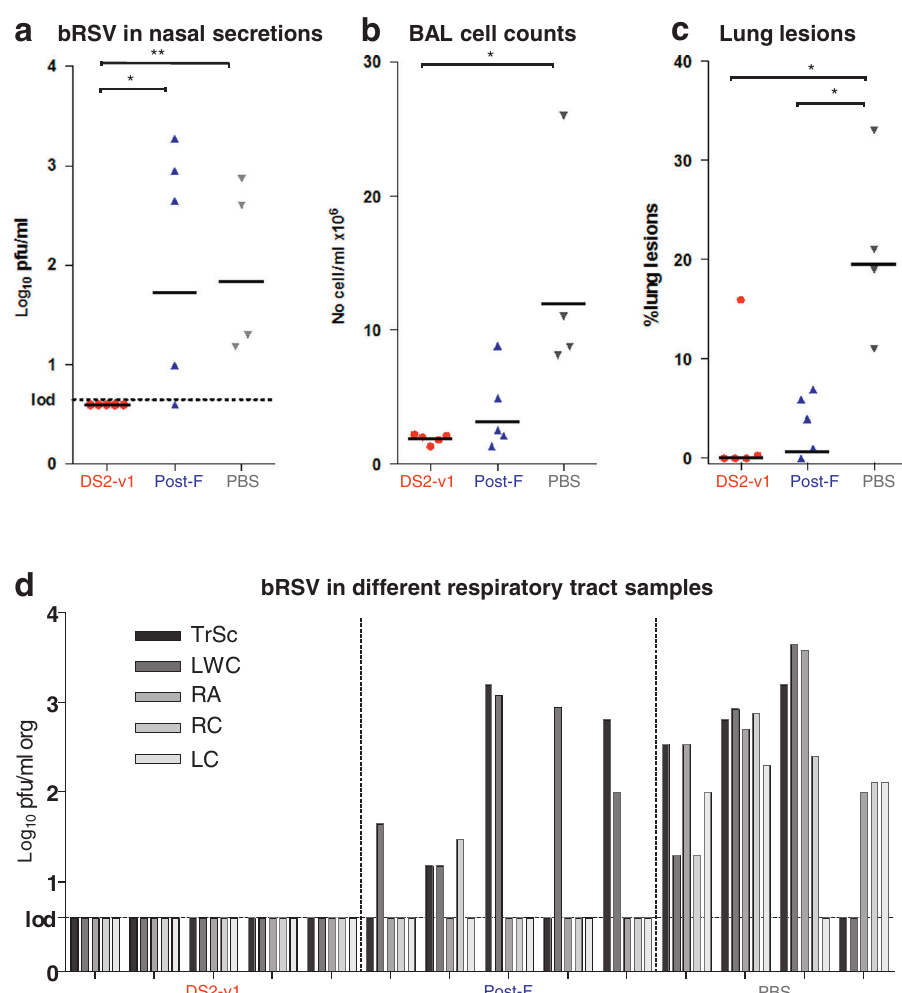
Fig. 4 Effect of vaccination on bRSV replication in the respiratory tract of calves and on pulmonary pathology. a Peak titers of bRSV in nasal secretions. Each dot represents the virus titer from nasopharyngeal swabs obtained at day 6 post challenge. Groups of fi ve calves were vaccinated with DS2-v1, Post-F (391-2 post-F), or PBS (Placebo in adjuvant). Geometric mean peak titers are indicated by black horizontal lines . b Effect of F protein vaccination on numbers of cells in BAL, 6 days after challenge with bRSV. c Analysis of percentage of lung with macroscopic lung lesions from photographs of lungs. d bRSV titers in samples of tracheal epithelium (TrSc), lung wash cells (LWC), and homogenates of samples taken from the right apical (RA), right cardiac (RC), and left cardiac (LC) lobes of the lung, 6 days post-infection. Each bar represents the bRSV titer of a lung sample. Each group of fi ve bars is from an individual calf. Titers are expressed as log 10 pfu/ml or g. The limit of detection (lod) is log 10 0.7 pfu/ml or g ( a and d ). Virus titers for each individual testing point are listed in Supplemental Table 8. P values were determined by two-tailed Mann – Whitney tests. *Indicates P ≤ 0.05, **indicates P ≤ 0.01, ***indicates P ≤ 0.001 and ****indicates P ≤